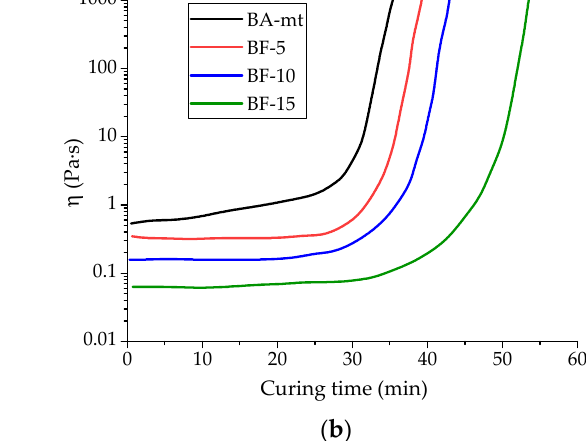
ence of the reciprocal viscosity 1/ η on time at the final stages of curing [35]. This dependence